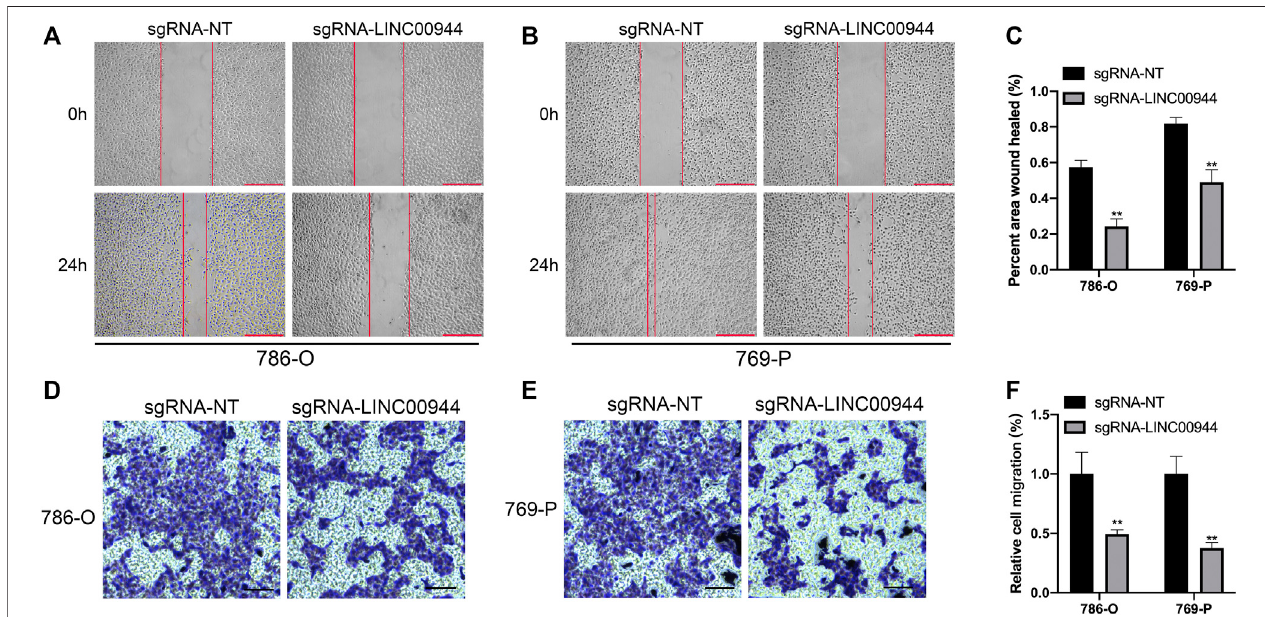
FIGURE 4 | Downregulation of LINC00944 inhibited the migration of RCC cells. (A – C) Wound-healing assays for migration ability of 786-O and 769-P RCC cells transfected with dCas9-KRAB and sgRNAs. (D – F) Transwell assays for migration ability of 786-O and 769-P RCC cells transfected with dCas9-KRAB and sgRNAs. ** p <